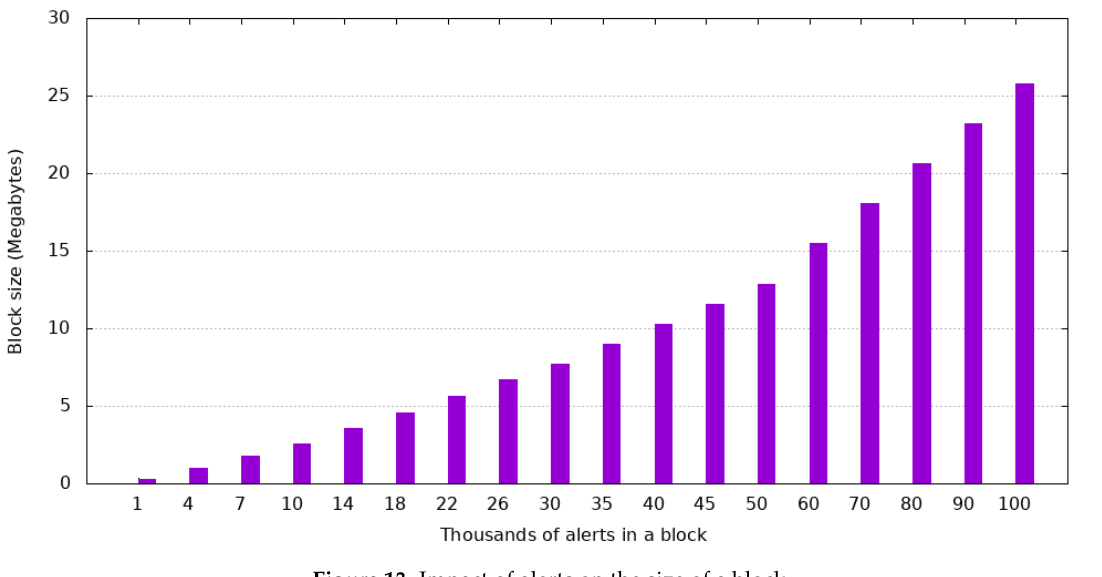
Figure 13. Impact of alerts on the size of a block.